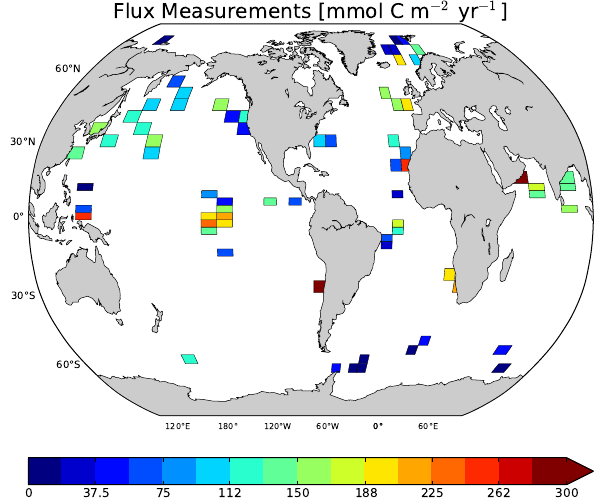
Figure A5. The global sediment trap data collection of Wilson et al. (2012, see their auxiliary material at doi:10.1029/2012GB004398) on the Bern3D grid. The measurements are located at different depths ( > 1500m). If more than one measurement was assigned to the same cell, the mean was